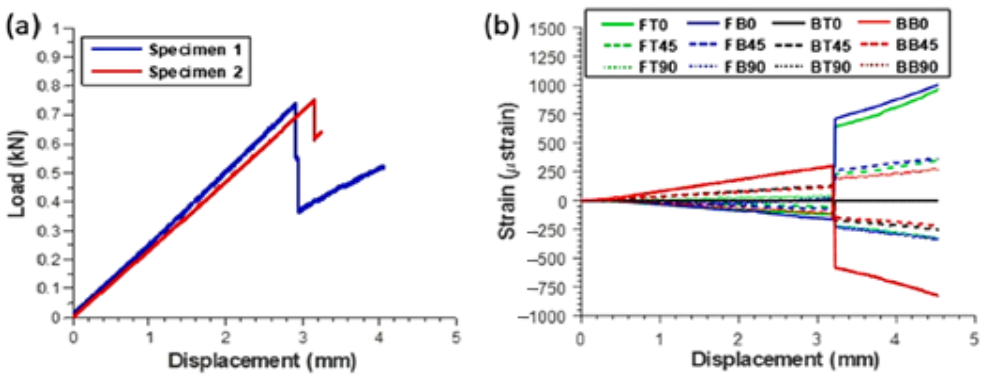
Figure 3. ( a ) Load displacement data and ( b ) strain gauge measurements for the static test [9].